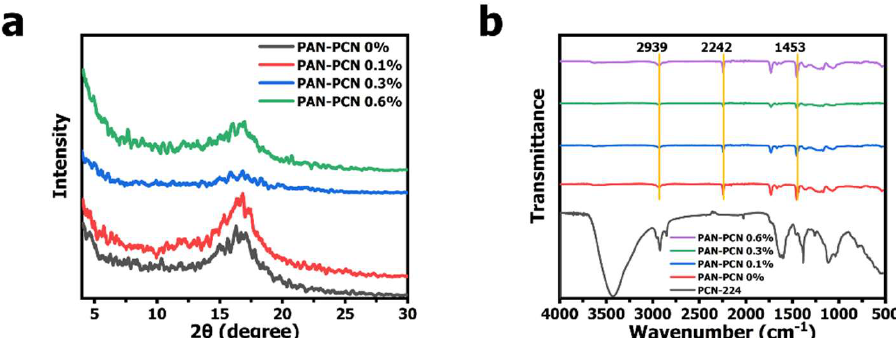
Figure 4. ( a ) X-ray diffraction (XRD) patterns of PAN-PCN 0%, PAN-PCN 0.1%, PAN-PCN 0.3% and PAN-PCN 0.6%. ( b ) FT-IR spectra of PCN-224, PAN-PCN 0%, PAN-PCN 0.1%, PAN-PCN 0.3% and PAN-PCN 0.6%.